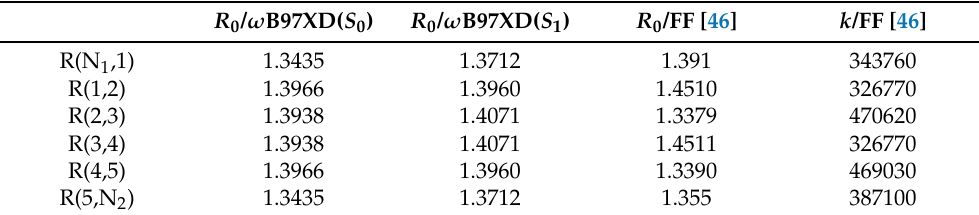
Table 1. Comparison of the polymethine equilibrium bond lengths ( R 0 ) in Å obtained from: the equi- librium structures of the ground ( ω B97XD ( S 0 ) ) and the first excited ( ω B97XD ( S 1 ) ) state optimized using ω B97XD/Def2SVP; and the equilibrium bonds from Amber99SB-dyes force field (FF) [46]. k /FF is the force constant in kJ mol − 1 nm − 2 obtained from Amber99SB-dyes force field (FF) [46]. The polymethine bonds are defined in Figure 1. The newly used equilibrium C-C bond length is 1.3970 Å and the force constant is 389,275 kJ mol − 1 nm − 2 . These values correspond to cag-cag bond parameters as implemented in the Amber99SB-dyes force field [46]. The newly used equilibrium N-C bond length is 1.3550 Å and the force constant is 387,100 kJ mol − 1 nm − 2 , which corresponds to c2g-nhg [46] bond parameters. cag, c2g, and nhg are the atom-type [46]. The FF parameters are